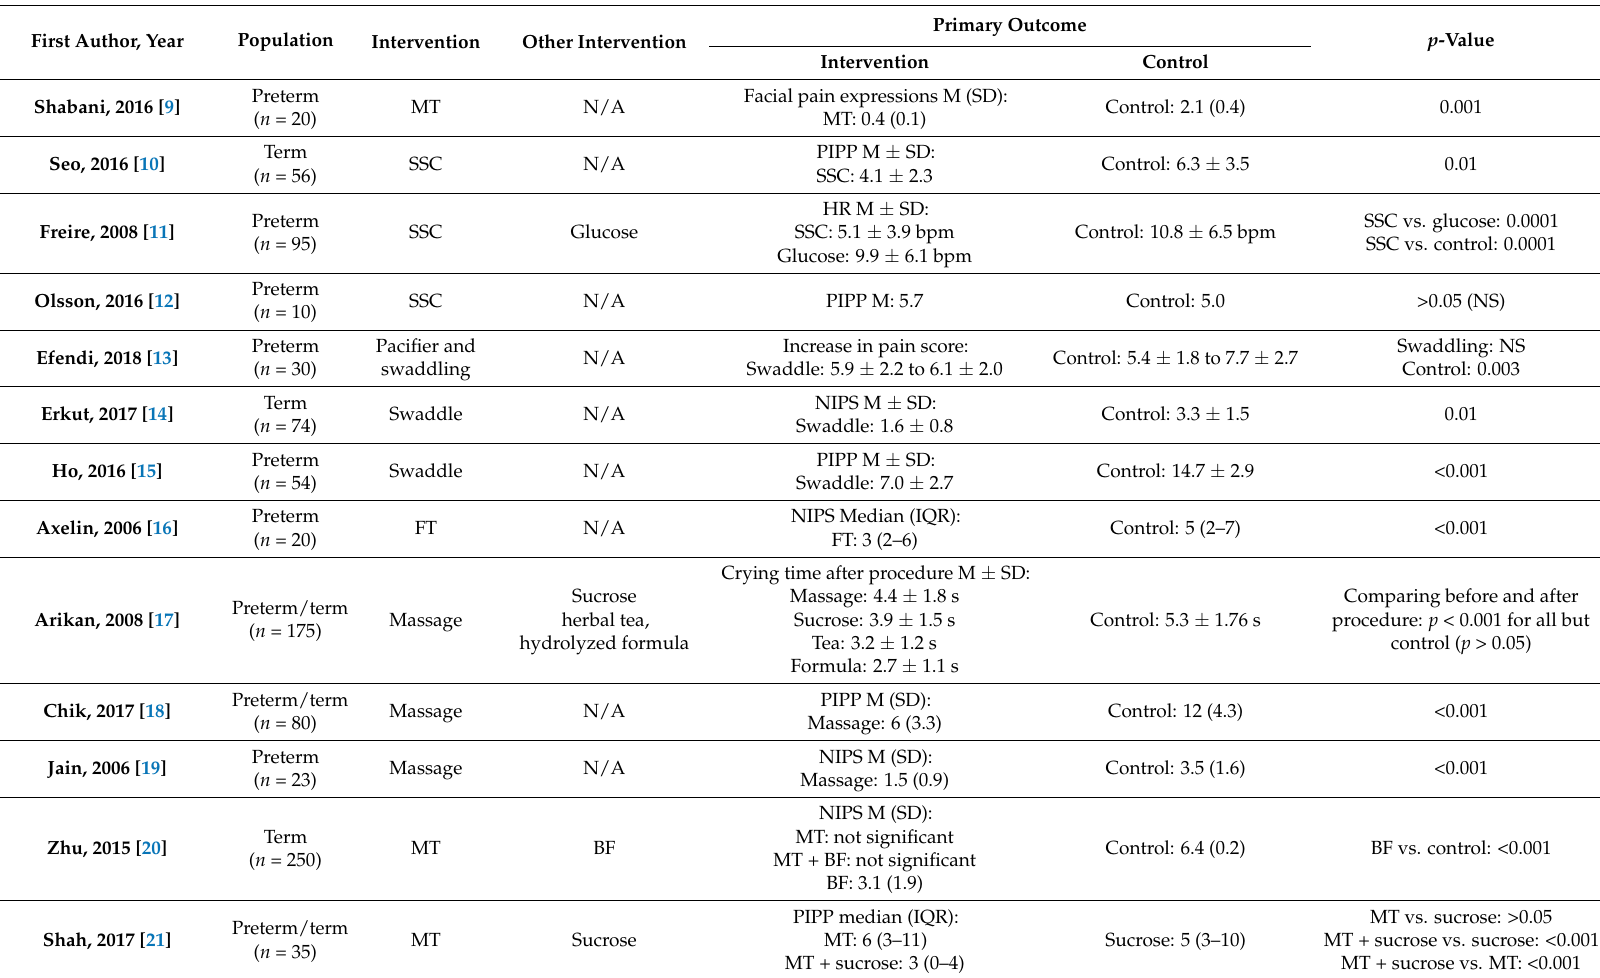
Table 2. Randomized controlled trials for non-pharmacological methods of pain relief in